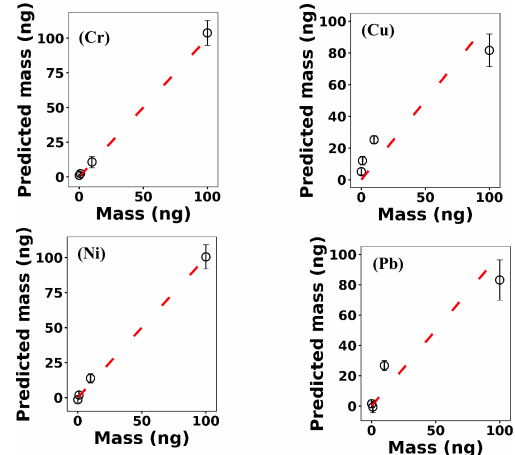
Figure 11. The optimized LASSO models predictions for Cr, Cu, Ni, and